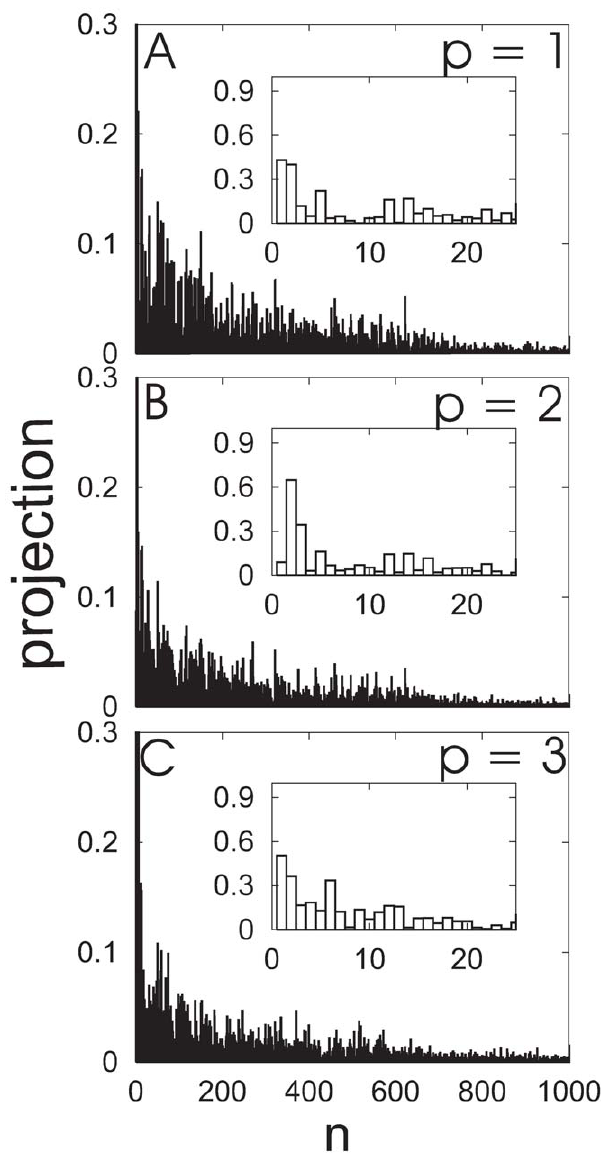
Figure 13. Projections of the principal components on the normal modes for PDC109. (A) p=1, (B) p=2, and (C) p=3. Insets show a magnified view for low frequency modes.